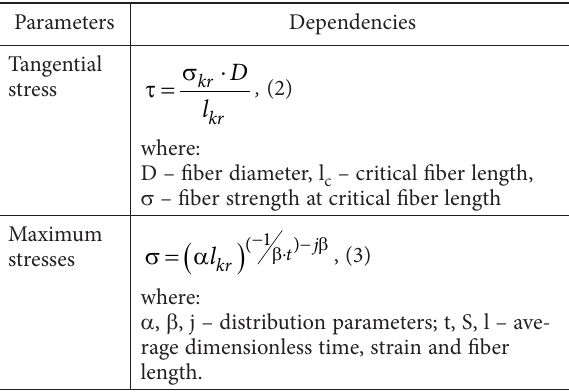
Figure 6. The fragment of the fiber contact with the base (a) and the base with the mesh (b) in the copper structure